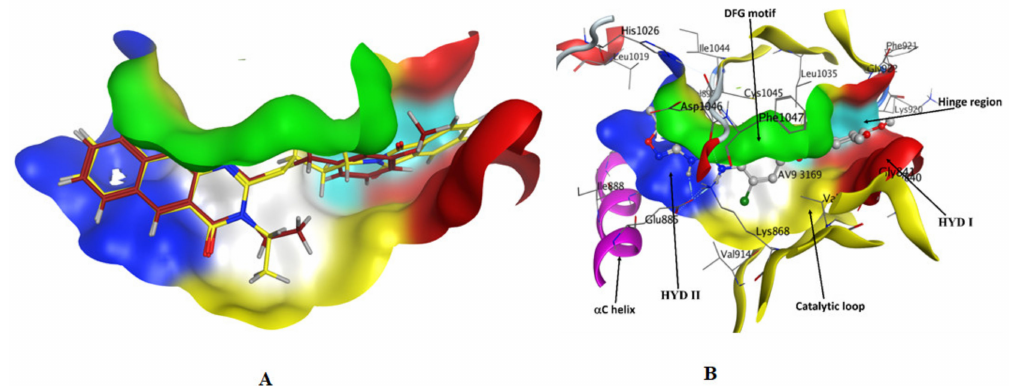
Figure 7. ( A ) 3D visualization of 13 (red) and 15 (yellow) in fully active VEGFR2 ATP binding pocket residues; ( B ) 3D visualization of the fully active VEGFR2 ATP binding pocket residues. The residues are colored according to the regions.